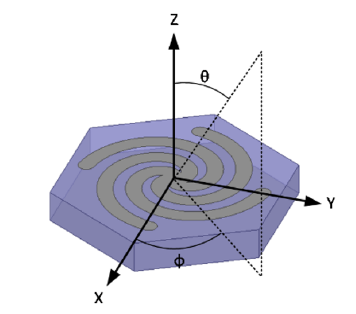
Figure 3. Representative coordinate system denoting the incoming electromagnetic (EM) signal orientation and used in the oblique incidence ( θ ) and polarization ( φ ) simulation